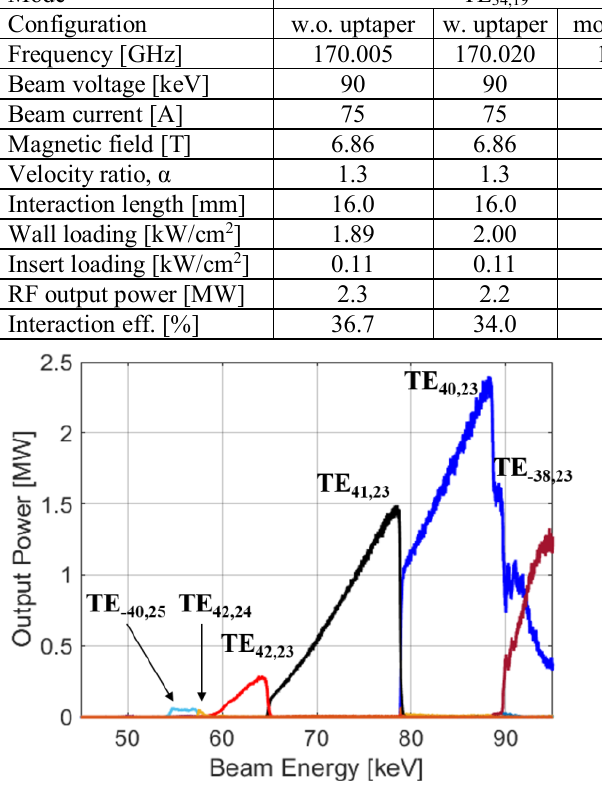
Table 2. Summary of the realistic multi-mode simulation results using EURIDICE using the new Tesla magnet configuration .